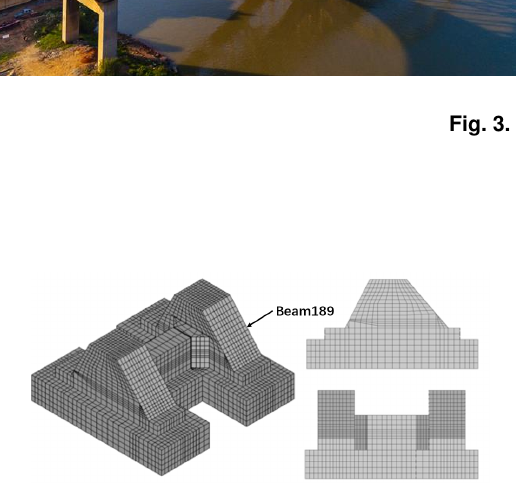
Fig. 4. The finite element model of arch-pedestal substructure